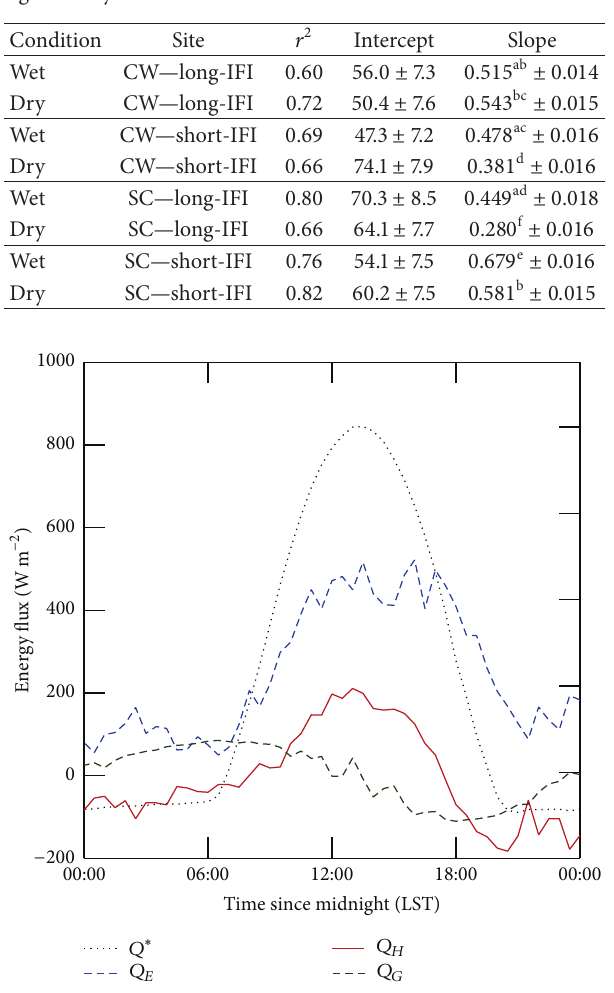
Table 4: Analysis of covariance comparing evaporative fraction between sites and drought condition. None of the intercepts ± standard error are significantly different ( 𝑝 < 0.05 ) from the single line intercept ( 59.4 ± 2.4 ). Slopes ± s.e. with the same letter are not significantly different.